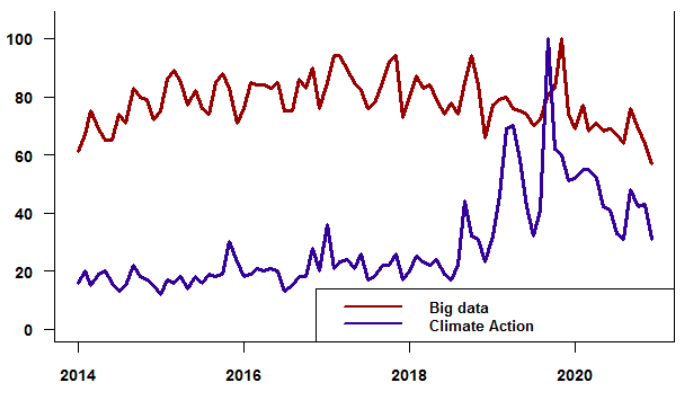
Figure 14. Big Data and SDG 13 global Google trends since